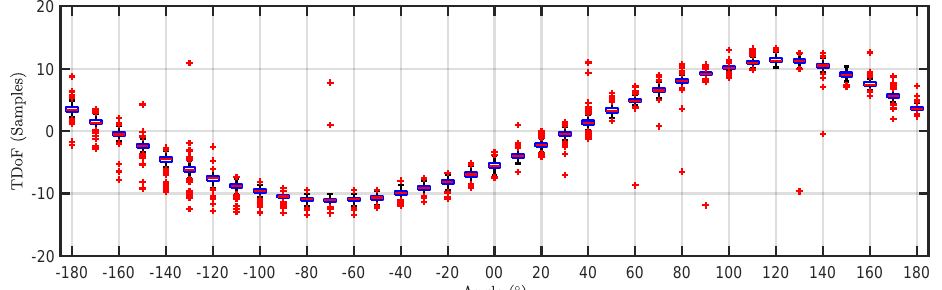
Figure 15. Box plot of the time differences of arrival versus angle of rotation for the pulses generated by source 2 in 3D localization.